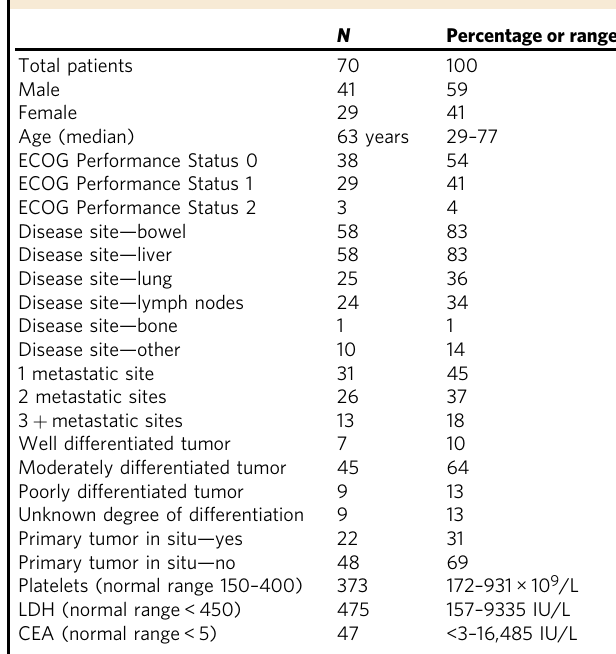
Table 1 Baseline patient